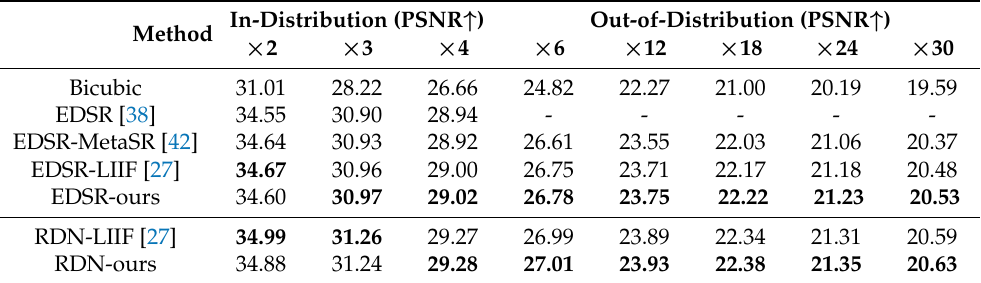
Table 3. Quantitative comparison on the DIV2K validation set (PSNR (dB)), the bold in table is the highest value.